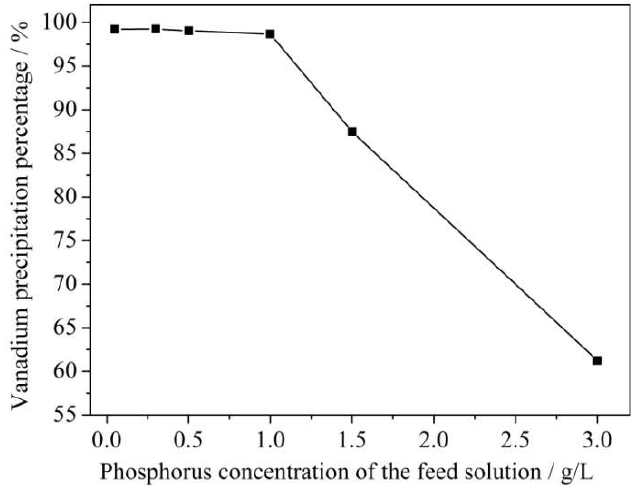
Figure 5. The effect of phosphorus concentration of the feed solution on the vanadium precipitation percentage.